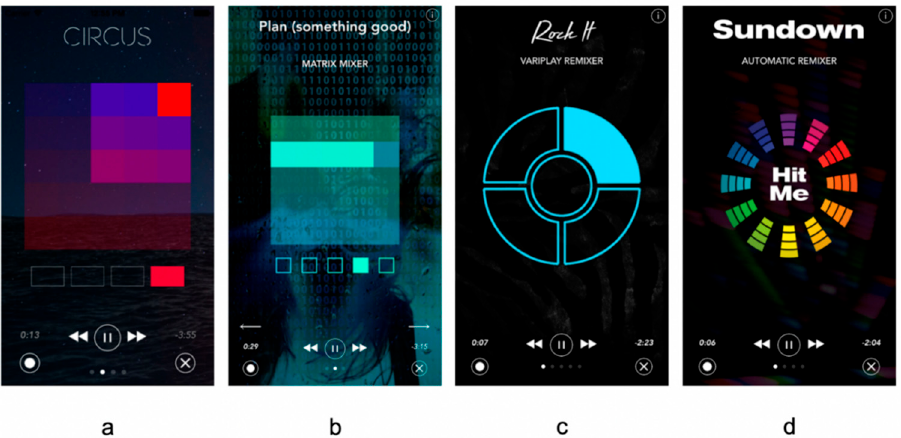
Figure 10. ( a – d ) Increasing simplification of user control. The colored blocks in the SUNDOWN app